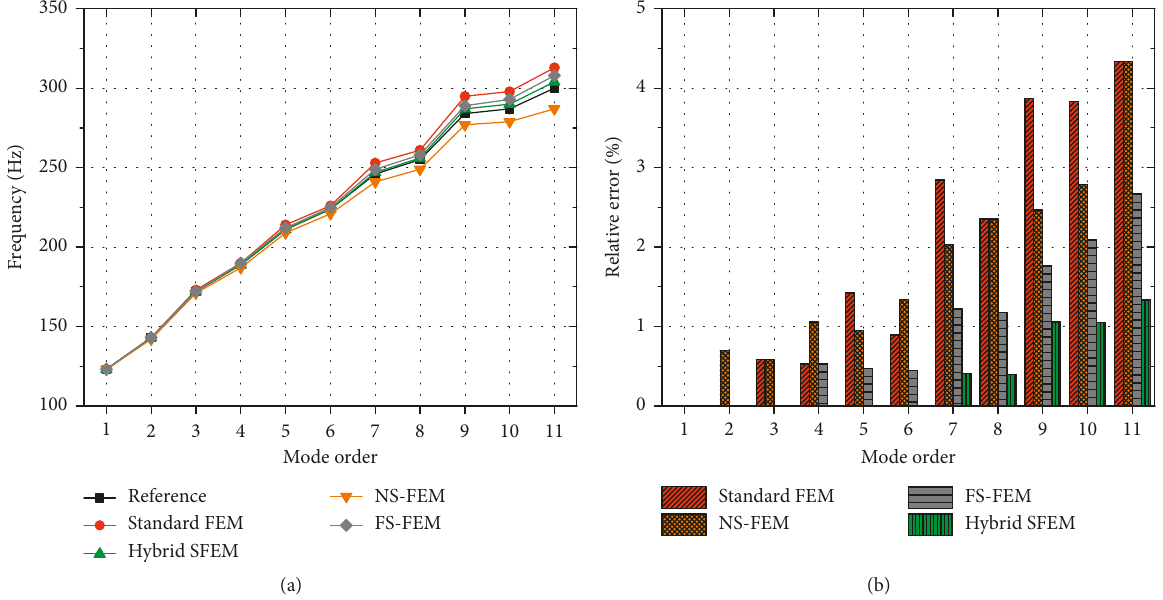
Figure 4: (a) The first 11 modal frequencies obtained by the reference method, standard FEM, hybrid SFEM, NS-FEM, and FS-FEM. (b) The relative errors of the standard FEM, hybrid SFEM, NS-FEM and